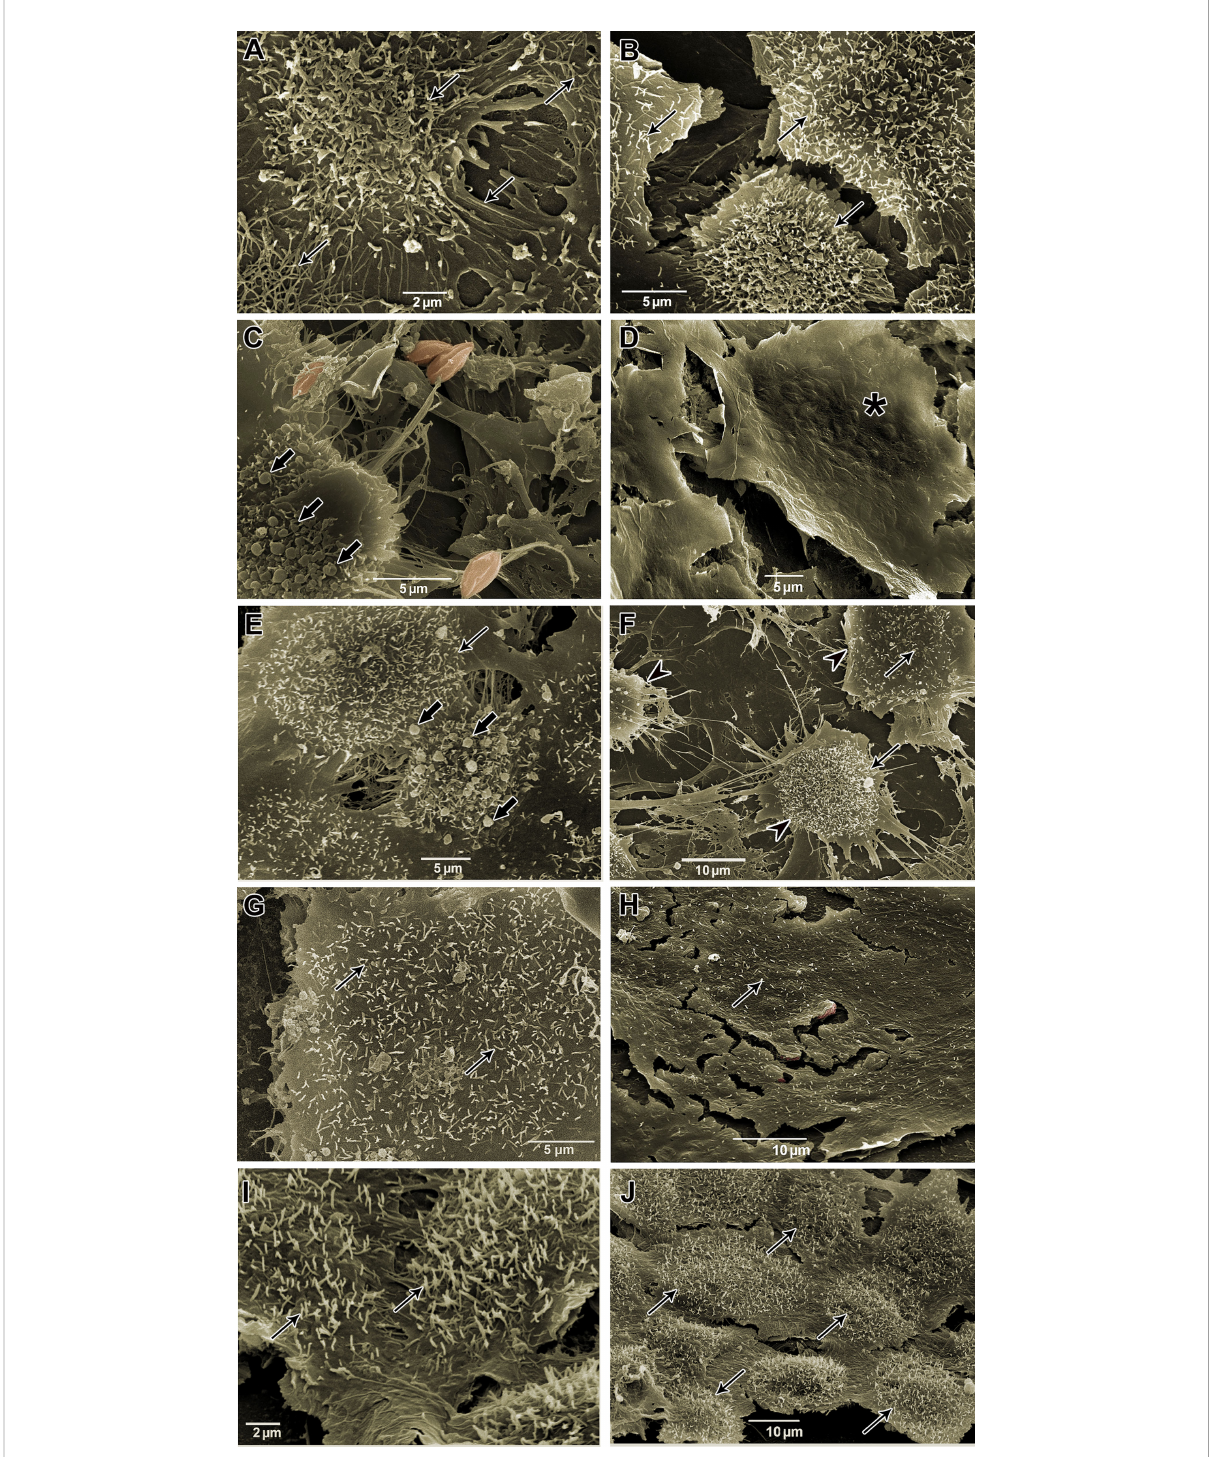
FIGURE 9 Scanning electron microscopy of T. cruzi -infected HCs treated for 72 h with Bz, AMD or their combination, demonstrating the predominance of the phenotype generated by Bz in the combination Bz + AMD. (A, B) Uninfected cells (NI); (C, D) Infected and untreated cells ( Tc ); (E, F) AMD MT (IC 50 /72 h = 2.5 m M); (G, H) Bz MT (IC 50 /72 h = 5.4 m M); (I, J) Bz:AMD Comb (Bz: IC 50 /72 h = 1.3 m M; AMD: IC 50 /72 h = 2.5 m M). Parasites were digitally colored in red. Black thin arrows indicate cytoplasmic projections, similar to fi lopodia; arrow heads indicate cytoplasmic retraction; black arrows indicate apoptotic body-like vesicles, and asterisk shows surface protrusions compatible in size with the presence of intracellular